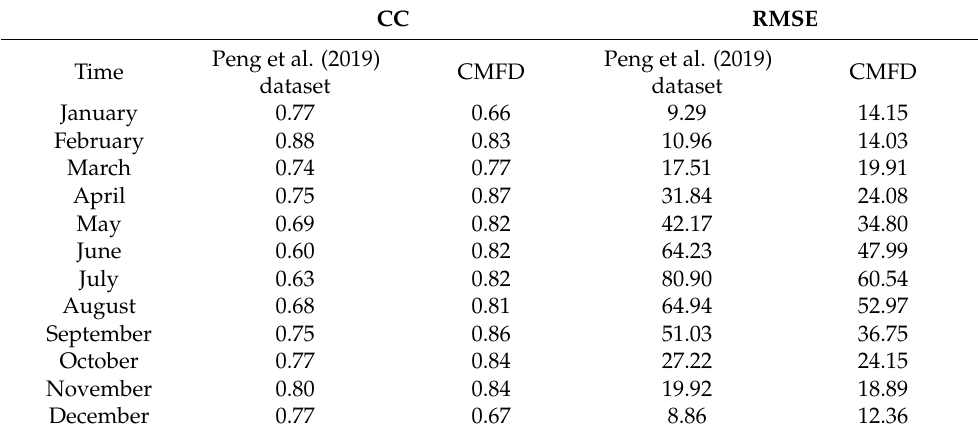
Figure A1. Density scatterplots of the monthly precipitation from ( a ) China Meteorological Forcing Dataset (CMFD) and ( b ) Peng et al. (2019) dataset versus ground-based observation. The black dashed line is the 1:1 line. n: valid number of samples; CC: Pearson correlation coefficient; RMSE: root-mean-square error of the monthly precipitation (mm); The color-coded dots represent the number of samples. Table A1. Statistical metrics summarizing the performance of monthly precipitation estimates based on different datasets relative to station observations (unit: mm/month for monthly data)